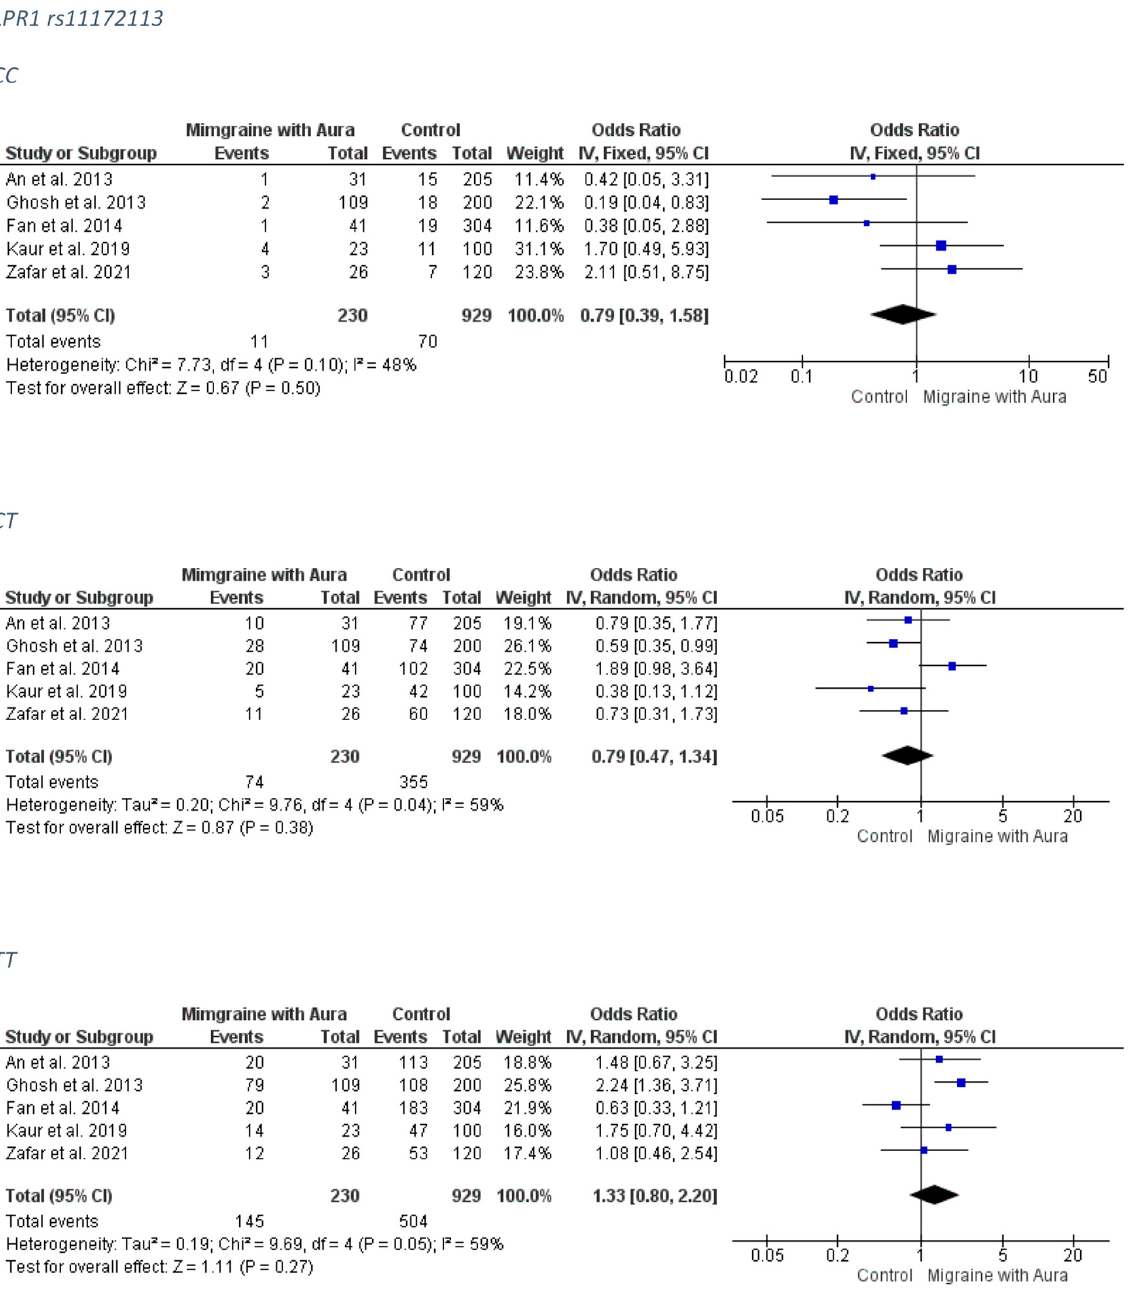
Figure 8. The forest plots presenting the results from meta-analysis of the rs11172113 and migraine with aura group .